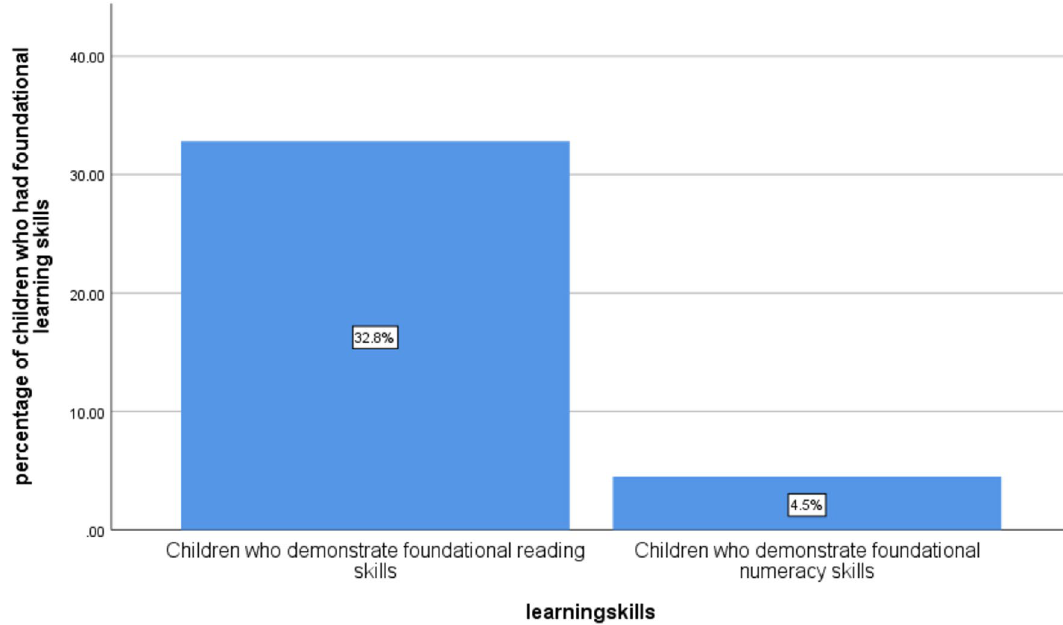
Figure 3. Foundational Learning skills of Children of Age 5–17 Years of Punjab. Source: MICS for children aged 14 years. This shows that learning skills improved with age increase in age at the beginning of the school of the child. But after 11 or 12 years, the increase turned into a decrease. Surprisingly, the percent- age of children having sufficient numeracy skills is higher for those children who had any functional disability (4.72%) as compared to those children that had not any functional disability (3.53%). The percentage of children with satisfactory reading skills is higher for those who had no functional disability (37%) as compared to those who had a functional disability (30.1%). A similarly rising trend in the percentage of children who had ample numeracy skills and reading skills is found with an increase in the level of maternal education. The improve- ment in reading skills or numeracy skills went consistently higher with rising in maternal education level. The percentage of children who had adequate reading skills is higher for children for whom reading books is available in the appropriate language (37.4%). The percentage of children who had necessary reading skills is almost the same irrespective of care taker’s disability. But, the percentage of children who had adequate numeracy skills is higher (4.45%) for those who were cared for by a person without any disability. An increase in the percentage of children who had adequate reading skills or numeracy rises with an increase in the wealth index quintile. The percentage of children with acceptable read- ing and numeracy skills is higher for urban children as compared to their rural counterparts. The percentage of children with adequate numeracy skills is observed highest for the Sargodha division (10.2%) and lowest for the Rawalpindi division (1.7%). While the percentage of children with fundamental reading skills is highest for the Rawalpindi division (44.9%) and lowest for DG Khan (27.2%). The percentage of children with adequate learning skills both learning and numeracy skills are observed higher for parents who helped them in doing homework or were involved in academic activities (attended school meetings for educational/financial matters or school celebrations or to receive report card) as compared to children whose parents had not participated in academic activities of their offspring (Table 2). Binary Logistic regression models are fitted independently on the two response variables i.e. adequate reading skills (Table 3) and adequate numeracy skills (Table 4). Potential socio-economic, demographic factors named child background characteristics (sex of child, age of child at beginning of school, functional disability, mother’s education, availability of book for reading, caretaker disability, area of residence Division and wealth index) and parental involvement factors (anyone helps the child in homework, meetings at school for educational issues, meetings at school for financial issues, received report card of the child, attended school celebrations, attended school to discuss child progress) available in MICS 2017–2018 were used for the current analysis. The age of the child at the beginning of school remained significant in all models with a slight increase in the value of OR for model III (Table 3). Chances of children having adequate reading skills increase by 43% (OR = 1.43; CI = 1.41, 1.46) and 45% (OR = 1.45; CI = 1.37, 1.54) for per year increase in age of children at begin- ning of school in the child background characteristic model (Model I) and in the combined model (Model III) respectively. It is observed that children with no functional disability had significantly higher adequate reading skills (Table 3). In Model I, children with no functional disability had (OR = 1.38; CI = 1.24, 1.55) 1.38 times higher adequate reading skills as compared to children with functional disability. In model III, when controlled also for the parental involvement factor, the odds ratio (OR = 1.95; CI = 1.40, 2.71) is increased.